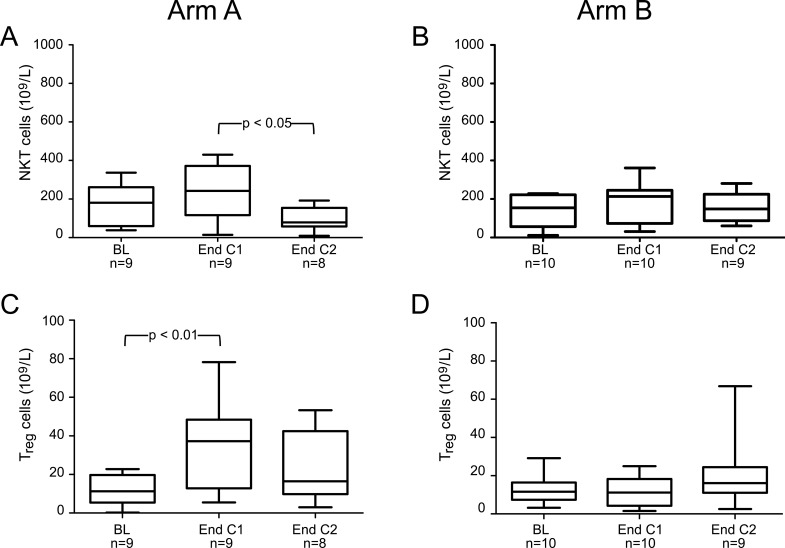
Absolute numbers of NKT-cells (CD3+CD56+CD16+) and regulatory T cells (Treg)(CD4+CD25+CD127-Foxp3+) at baseline (BL), at the end of cycle 1 (End C1) and at the end of cycle 2 (End C2) in part II patients treated with either lenalidomide monotherapy during cycle 1 with the addition of gemcitabine from cycle 2 (Arm A) (Left column) (Fig 4 A and C) or gemcitabine monotherapy during cycle 1 with the addition of lenalidomide from cycle 2 (Arm B) (Right column) (Fig 4 B and D). Changes in the absolute numbers of NKT-cells (A, B) and regulatory T cells (C, D) over the treatment course. n = number of patients analysed at each time-point. P-values refer to the comparison with BL, End C1 and End C2 by one way ANOVA with repeated measures. The box, with a line indicating median, represents the 25th and 75th percentiles. The top and bottom whiskers represent the 90th and 10th percentiles, respectively.